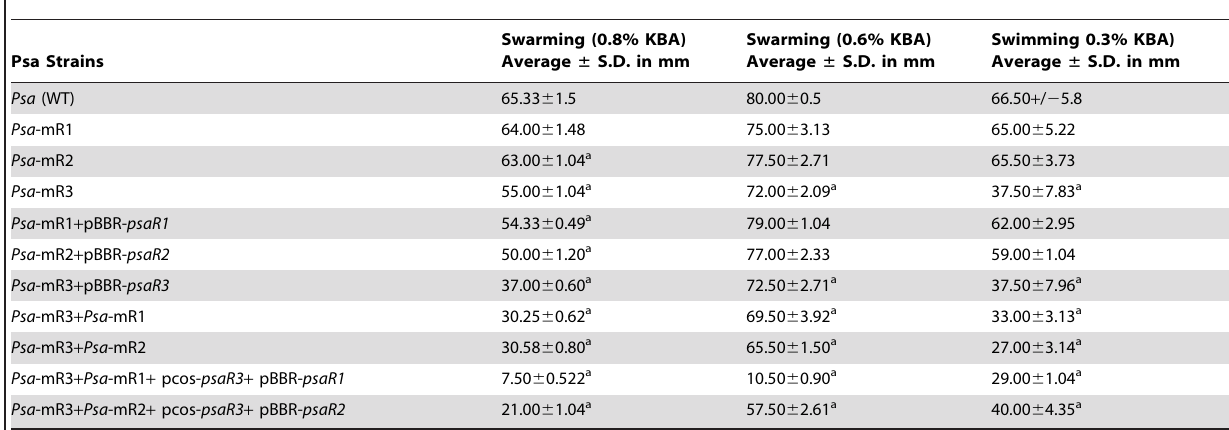
Table 5. Swarming and swimming movement score of Pseudomonas syringae pv. actinidiae strains.